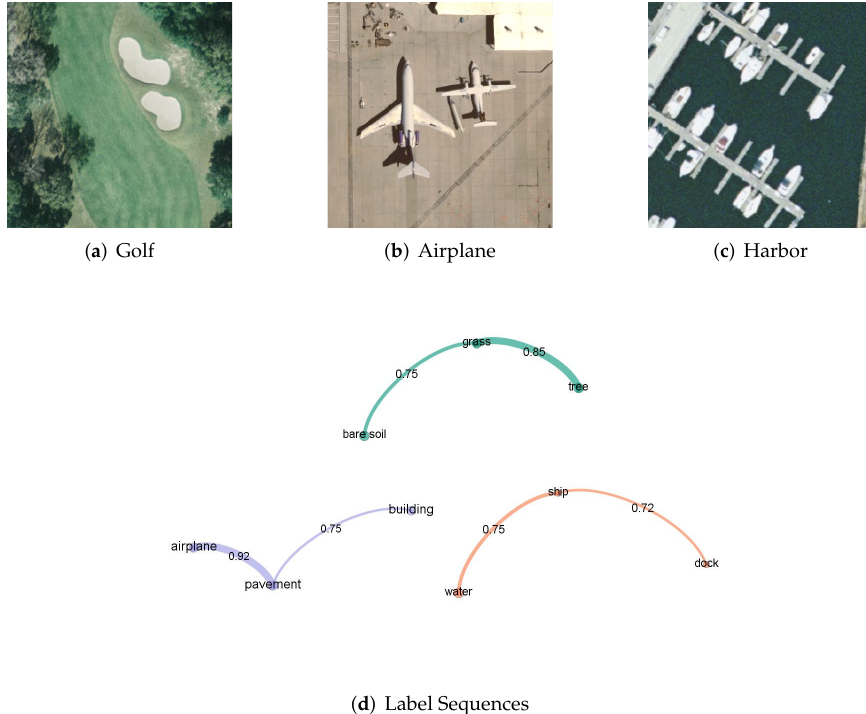
Figure 10. Label sequences of three typical pictures for LSTM